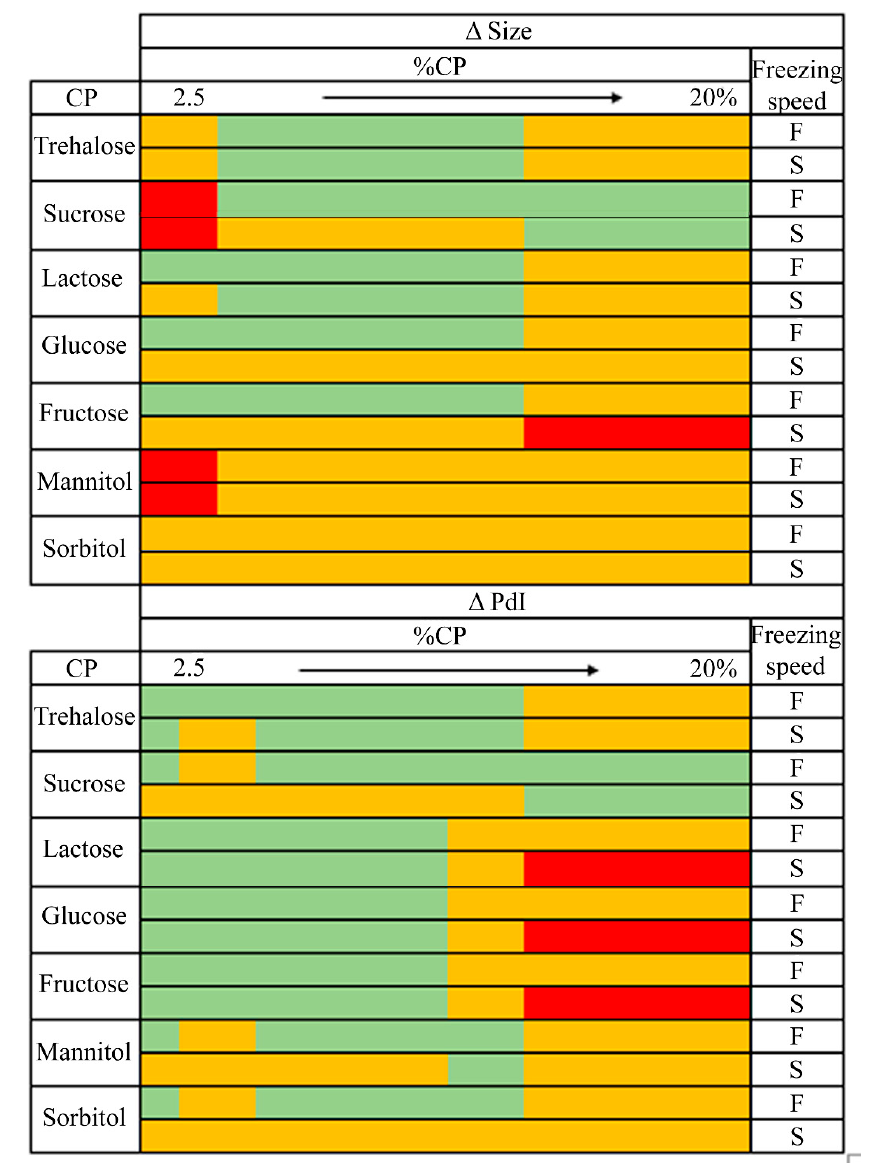
Figure 5. Traffic light system from NFL models for particle size and polydispersity index of NLCs. F: fast freezing speed. S: slow freezing speed. Highly advisable conditions in green, mediumly advisable in yellow, and not advisable in red.